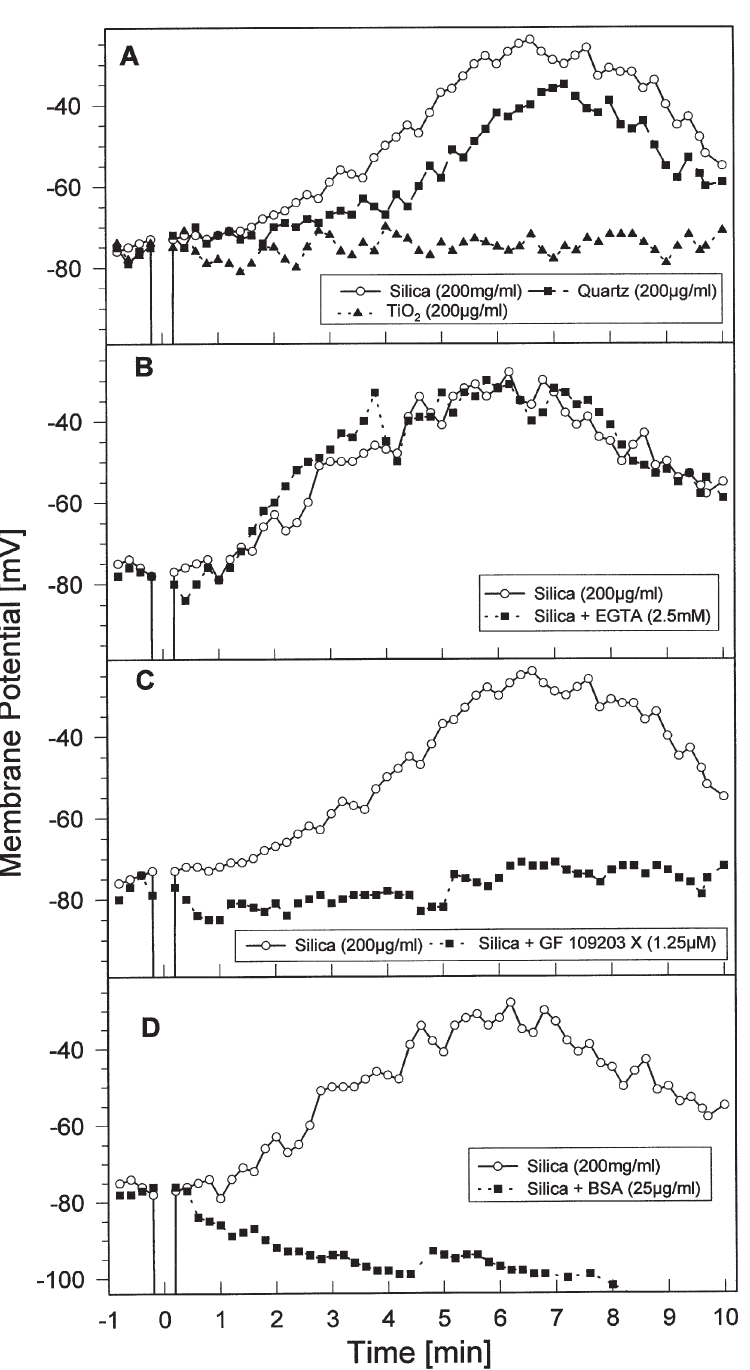
Fig. 4. Kinetics of apparent potassium potential of BAM after stimulation with silica (QUSO G 32) or TiO 2 (A), silica with or without preincubation with EGTA (B), 1.25 µ M GF 109203 X (C), and with untreated or BSA-coated silica (D). Data show tracings of single runs and are representative for at least 6 experiments. Experimental details as in Fig.